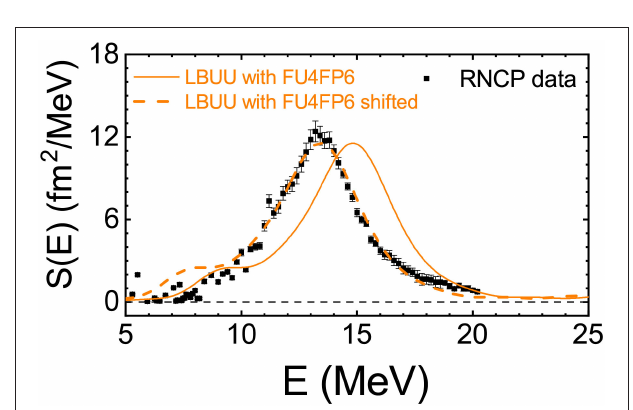
FIGURE 7 | Strength function of the GDR in 208 Pb after a perturbation ˆ H ex = λ ˆ Q IVD δ ( t − t 0 ) with λ = 15 MeV / c obtained from the LBUU calculation using the FU4FP6 parameterization [107] for the in-medium NN scattering cross-section. The strength function measured in the RCNP experiment [63] is also shown for